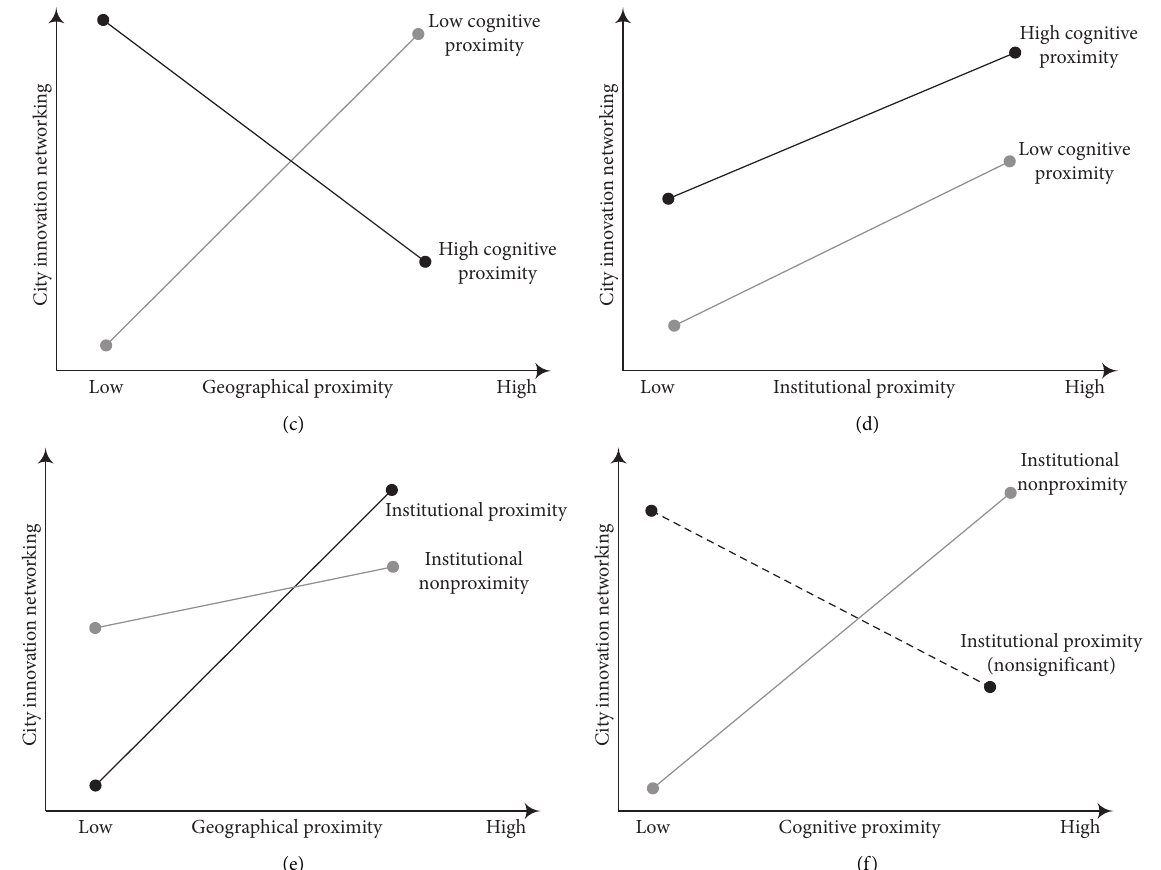
Figure 5: Regulatory effects of geographical, cognitive, and institutional